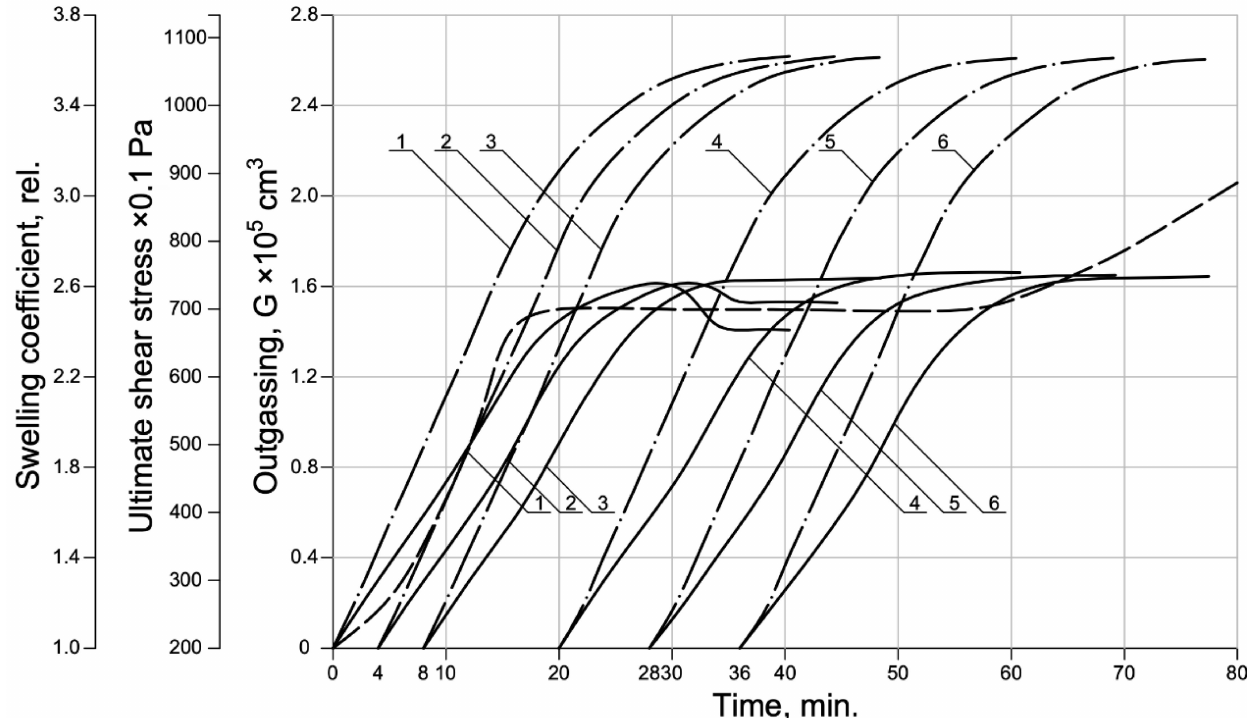
Figure 4. Kinetics of swelling of an aerated concrete mixture (simulation): 1–6 are experiment numbers. The initial data for the calculation according to the model were